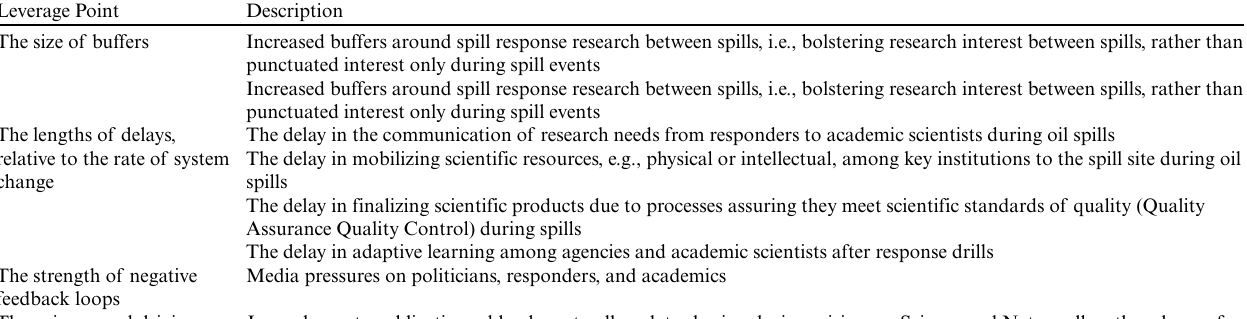
Table 2 . The 20 leverage points most powerful for achieving our four target